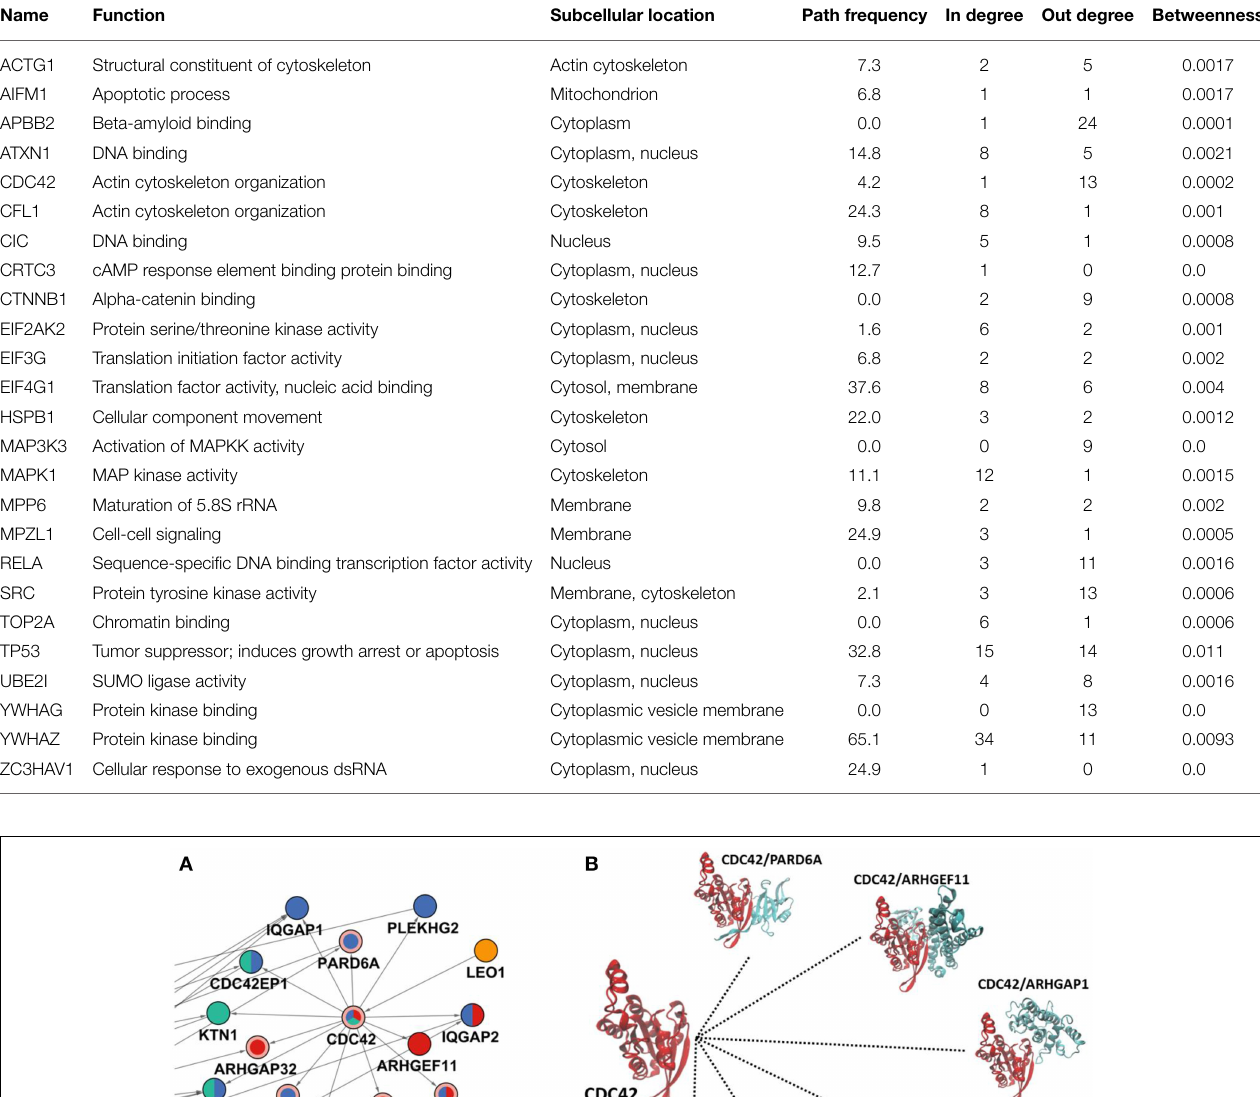
TABLE 3 | Top ranking proteins in the reconstructed network.